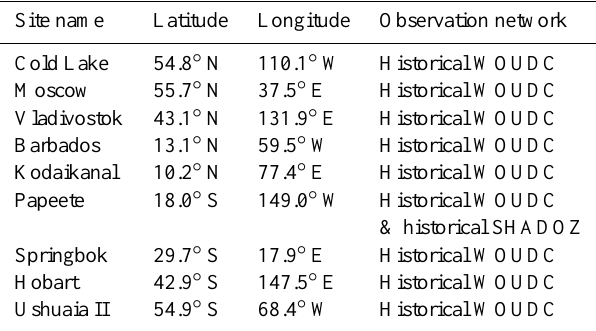
Table 4. Proposed measurement sites for the detection of ozone trends from 2010 to 2050.